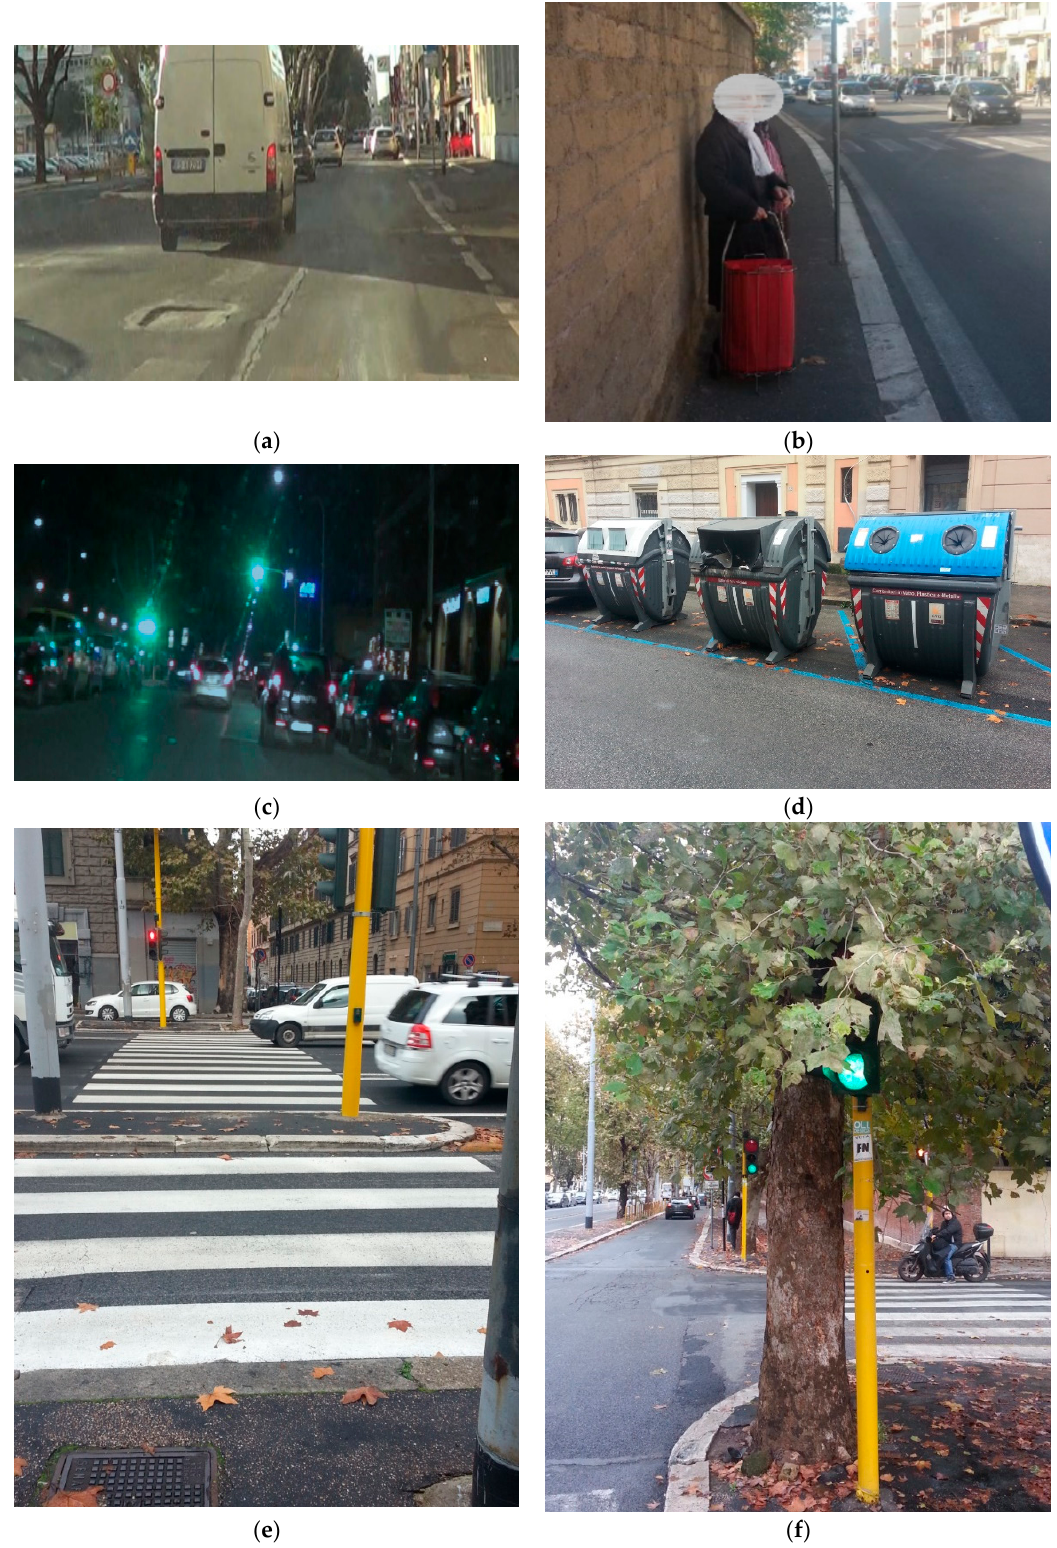
Figure 4. Most frequently detected distresses. ( a ) Irregular pavement P1 ( B i = 3); ( b ) Narrow sidewalk C6 ( B i = 2); ( c ) Inefficient lighting system L2 ( B i = 2); ( d ) Urban furniture occupies shoulder and/or lane F5( B i = 3); ( e ) Pedestrian crossing without ramps C13 ( B i = 2); ( f ) Not visible traffic light S11 ( B i = 2).